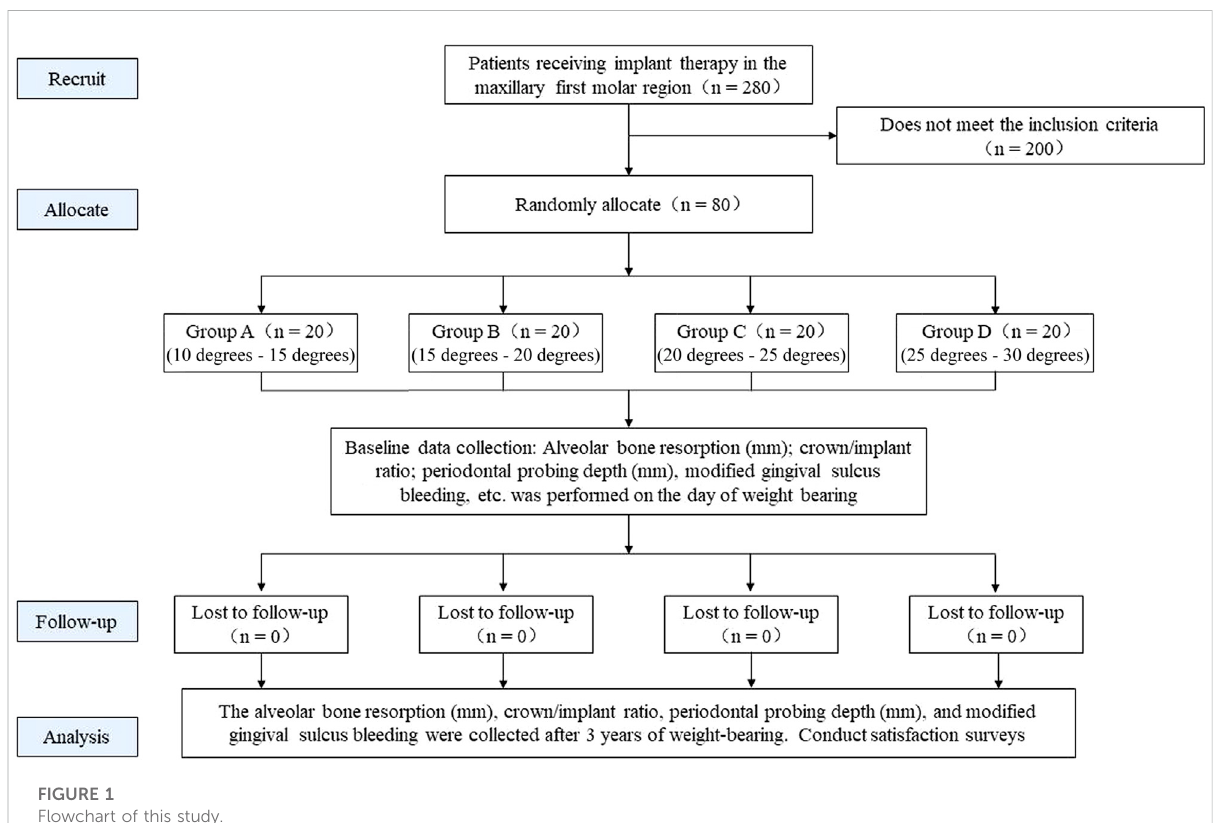
FIGURE 1 Flowchart of this